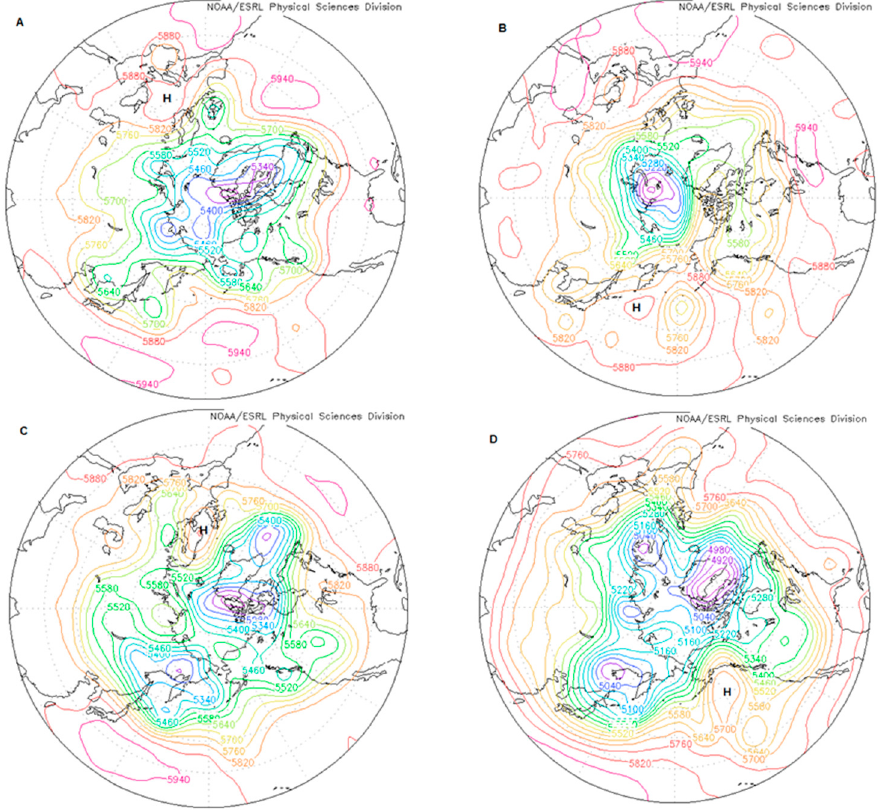
Figure 1. The 500 hPa height field for ( A ) 1200 UTC 24 June 2016 (weak Atlantic); ( B ) 1200 UTC 28 August 2016 (weak Pacific); ( C ) 1200 UTC 4 October 2016; and ( D ) 1200 UTC 24 February 2017. The center point at this time is labelled with an